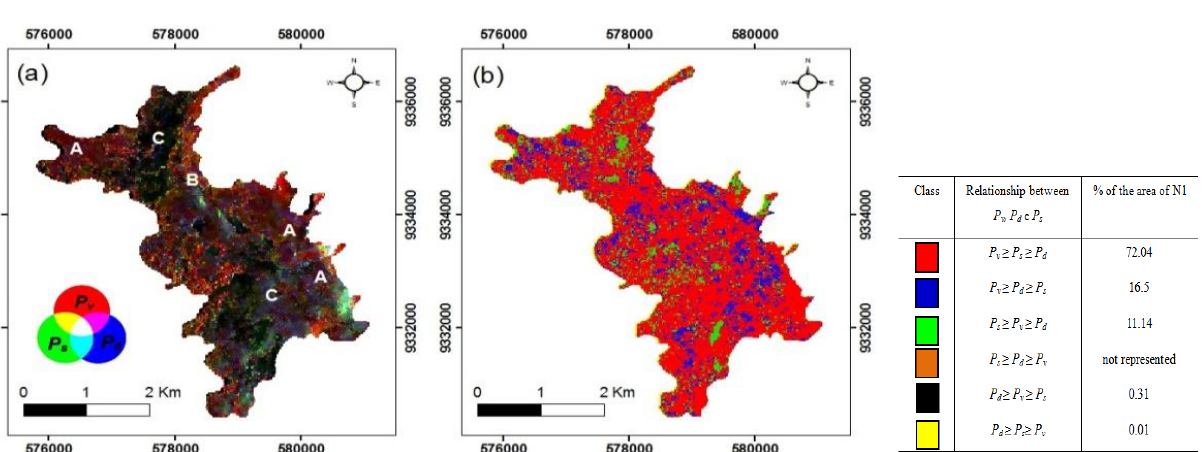
Figure 8. ( a ) RGB combination of the scattering mechanisms derived from the Freeman-Durden for the R99B images. The letters A, B, and C indicate colors associated with the relative contribution of the component mechanisms, as described in the text; ( b ) Classes labeled according to the relationship between the types of scattering mechanisms derived from the Freeman-Durden decomposition